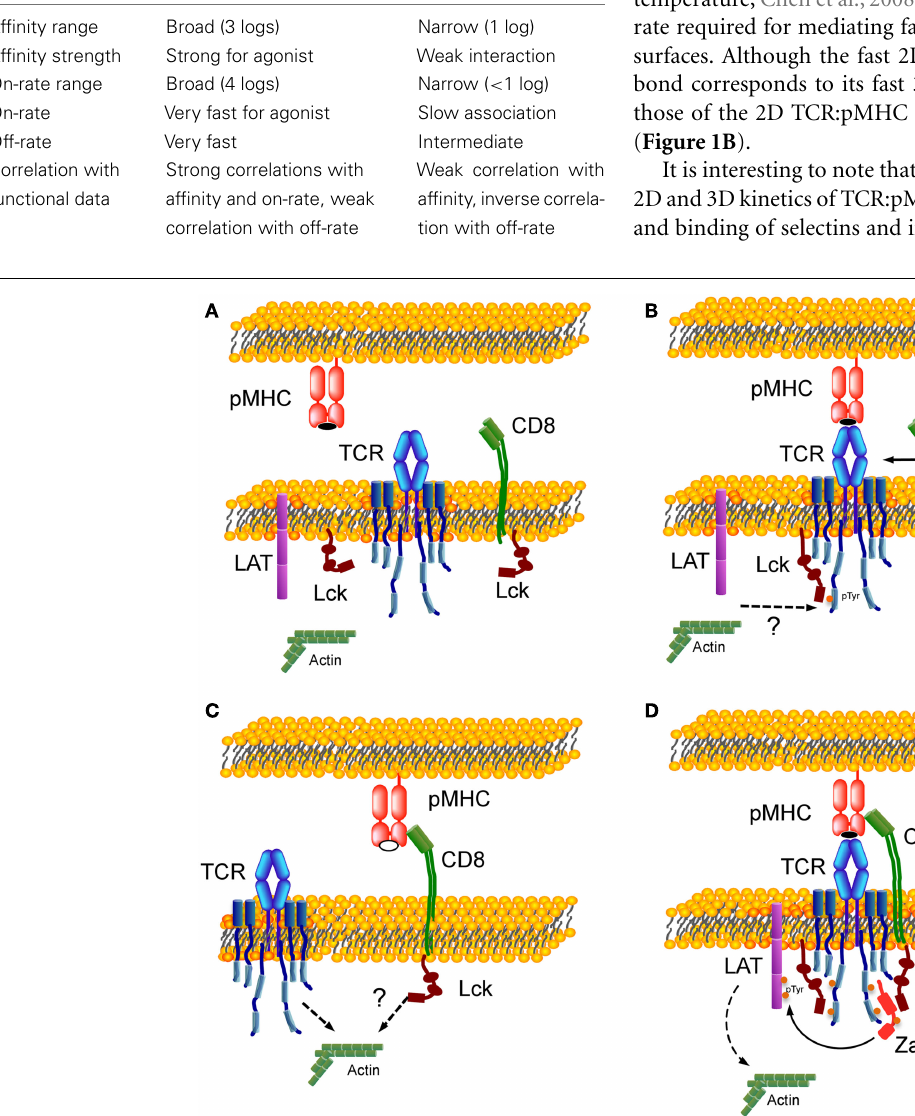
FIGURE 2 | Formation ofTCR:pMHC:CD8 trimolecular complex. (A) Resting state with no interaction betweenTCR, CD8, and pMHC. (B) Binding ofTCR with MHC complexed with agonist peptide (closed symbol) as a first step of the trimolecular interaction. (C) Weak interaction between CD8 and MHC bearing self-peptide (open